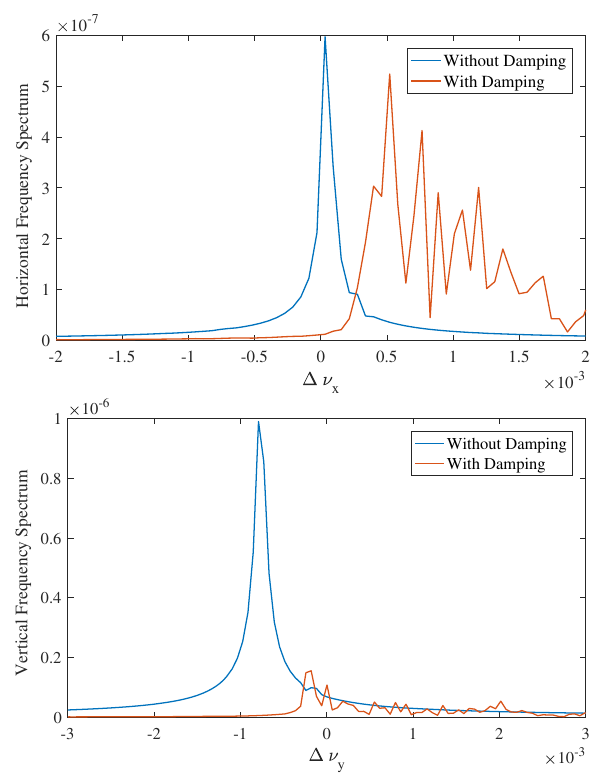
FIG. 20. Frequency spectrum of the beam centroid motion.